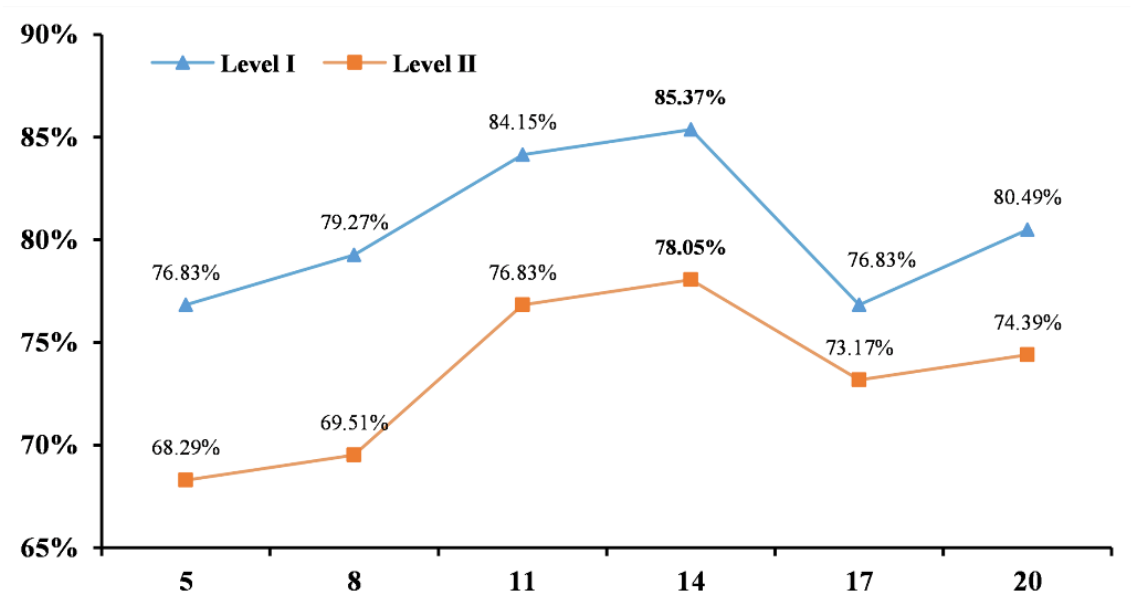
Figure 6. Effect of sample size on multiple-sample-voting strategy.